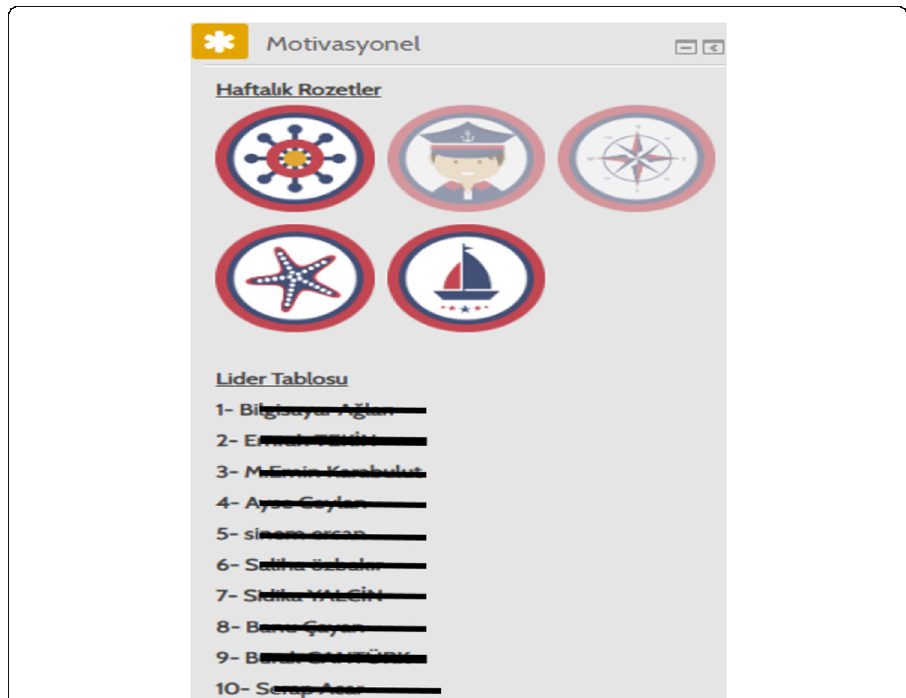
Fig. 5 Examples of Motivational